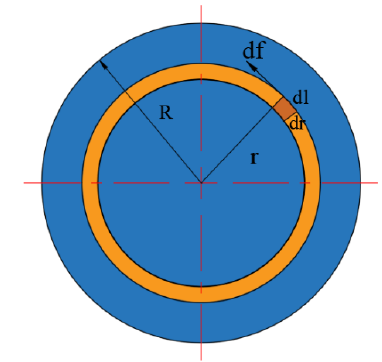
Figure 7. Analysis of the static friction moment of the